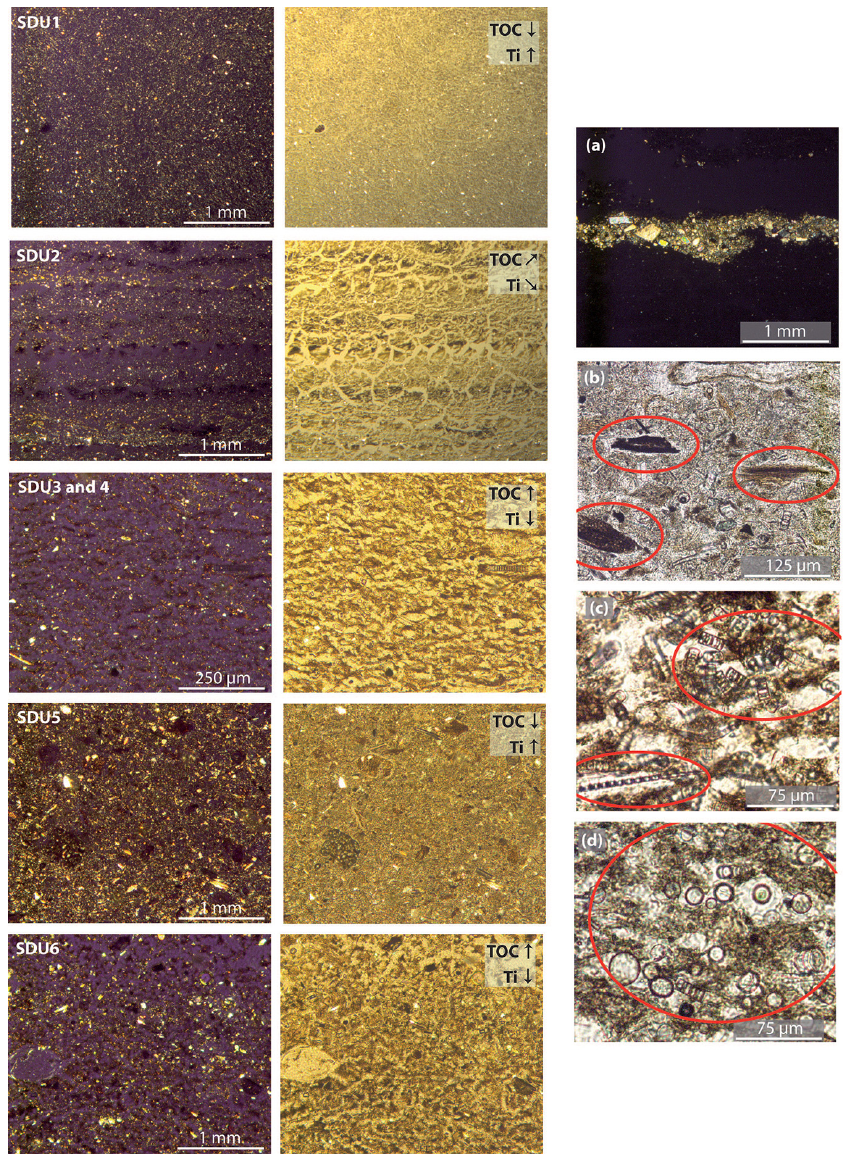
Figure 5. (left) Overview micrographs of Lake Kälksjön (KKJ) sediment deposition units (SDUs) 1 to 6 under polarized and plane light. Relative abundances of TOC and Ti contents in each SDU are indicated. (right) Micrographs highlighting individual sediment components. (a) Liming layer from 1993CE (5cm composite depth, polarized light), (b) terrestrial organic debris in SDU 5 (18cm composite depth, plane light), (c) diatom frustules (Aulacoseiraceae and Fragilariaceae) in SDU 3 (305cm composite depth, plane light) and (d) crysophyte cysts in SDU 3 (298cm composite depth, plane